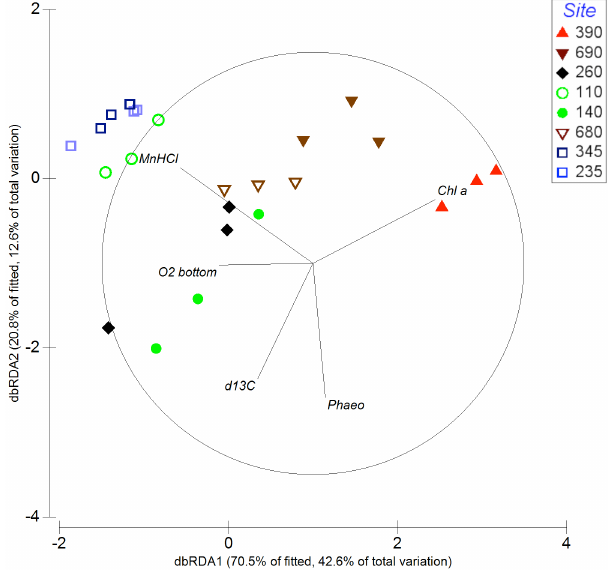
Fig. 4. Distance-based redundancy analysis (dbRDA) plot of the DistLM based on the environmental parameters fitted to the varia- tion in biogeochemical fluxes (Table 6). Vectors indicate direction of the parameter effect in the ordination plot. Chl a = natural logarithm of sediment Chl a concentration; dC13 = δ 13 C signature; Phaeo = sediment phaeopigment concentration; Mn HCl = sediment surface manganese oxide concentration; and O 2 bottom = bottom water oxygen concentration. Brown and red triangles: shallow Mackenzie Shelf and Delta; green circles: Cape Bathurst and Amundsen Gulf region (east); blue squares: deeper Mackenzie